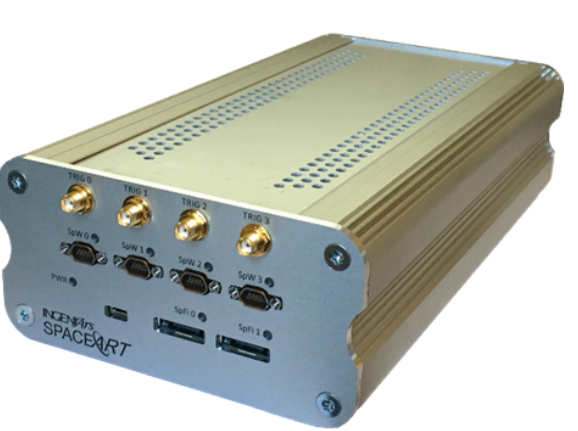
Figure 4. IngeniArs SpaceART Electrical Ground Support Equipment (EGSE) hardware